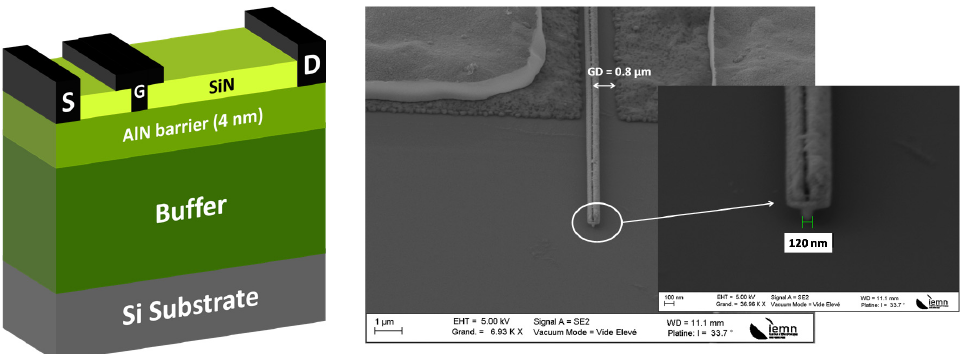
Figure 1. Cross-section of the fabricated AlN/GaN-on-Si HEMTs ( left ) and SEM images of the 120 nm gate technology ( right ).